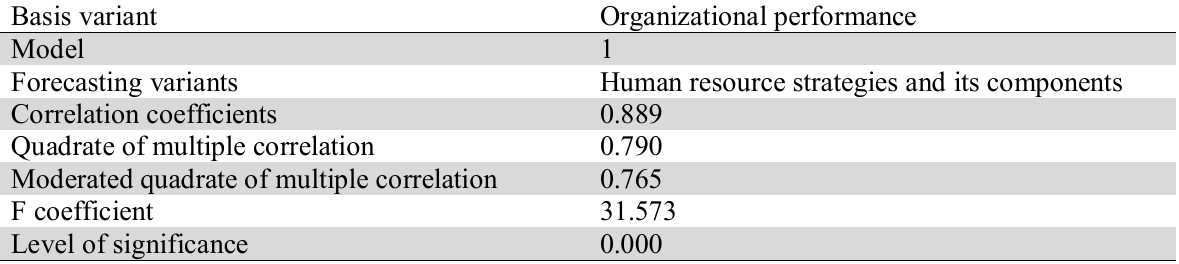
Table 3 Multiple correlation coefficients and the quadrate of multiple correlation of the components of human resources strategy in forecasting organizational performance